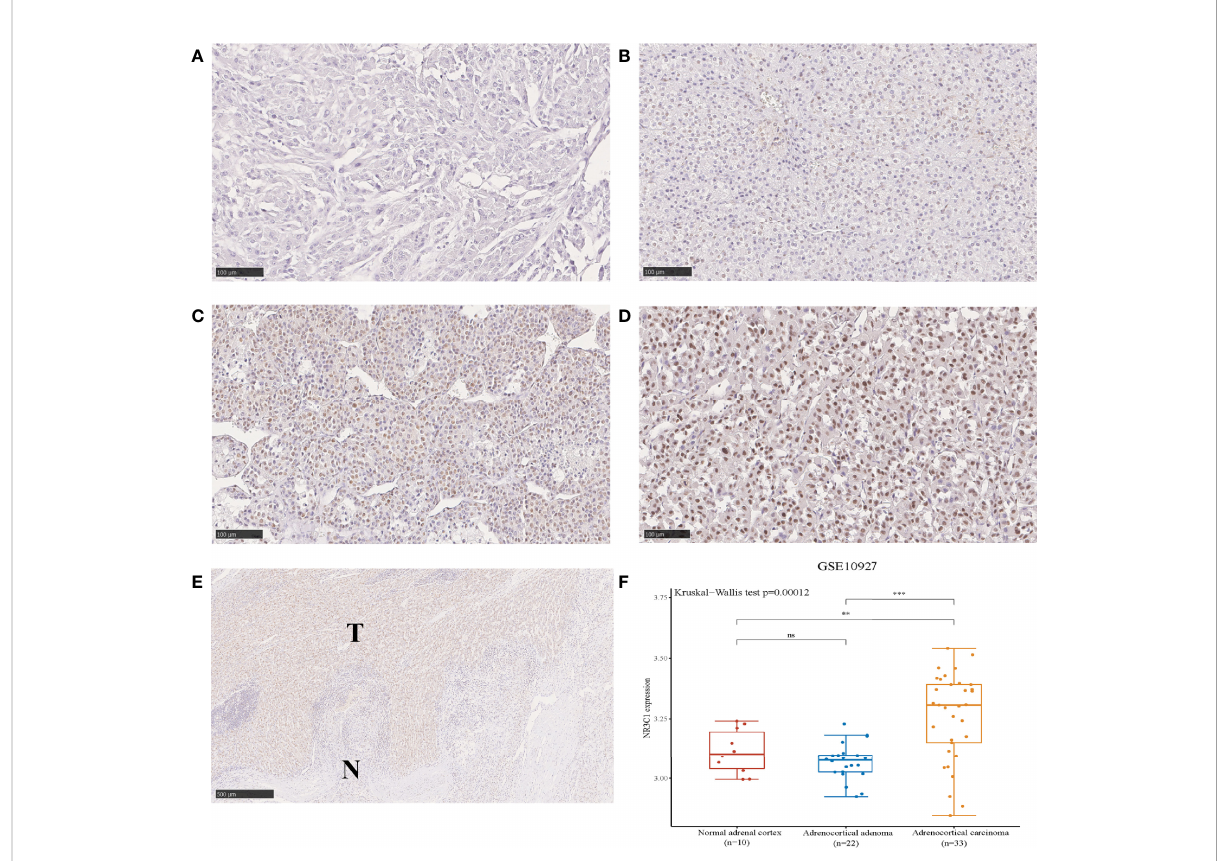
FIGURE 1 The protein expression of GR in ACC showing negative (A) , weak (B) , intermediate (C) and strong (D) intensities of GR expression in carcinomas (100 µm). Immunohistochemical staining shows the higher expression of GR in tumor tissues compared to adjacent normal tissues (E) . The expression distribution of GR gene in normal adrenal cortex, ACA and ACC (F) . *p < 0.05, **p < 0.01, ***p < 0.001; ns, no signi fi